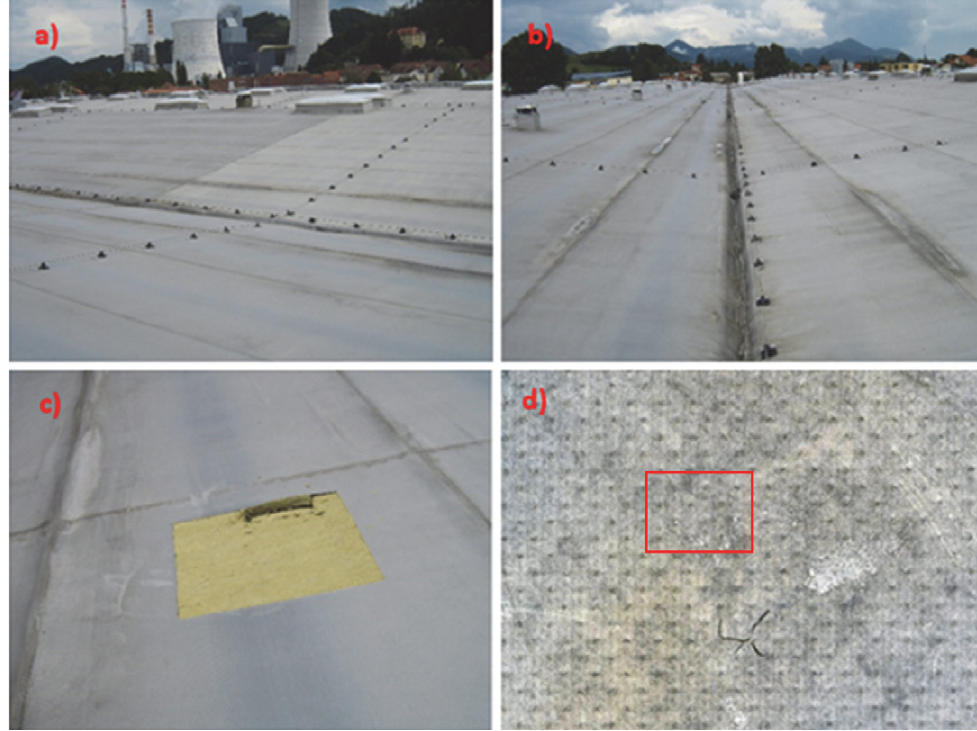
Figure 1. Plasticized PVC waterproofing membranes were taken from a flat industrial roof located in Slovenia, Central Europe (a, b) Extraction at sampling location 1 (c). Naturally aged and locally damaged plasticized PVC membrane